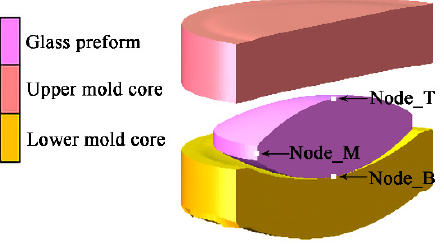
Figure 5. The diagram of the established three-dimensional geometry model of the molds and glass preform.